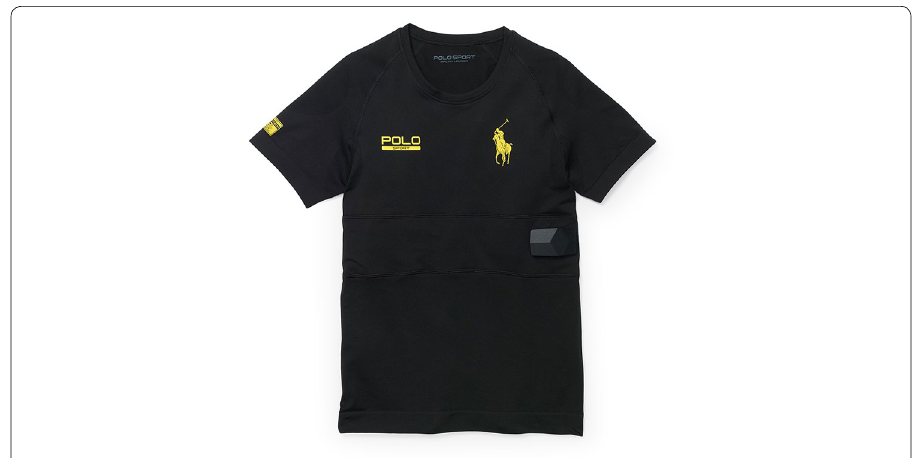
Fig. 7 Ralph Lauren Polo Tech shirt. Photograph: Courtesy of Ralph